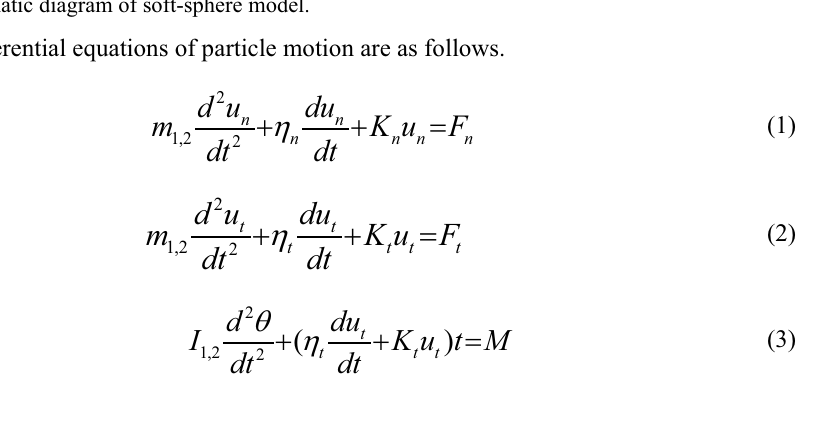
Fig. 4 . Schematic diagram of soft-sphere